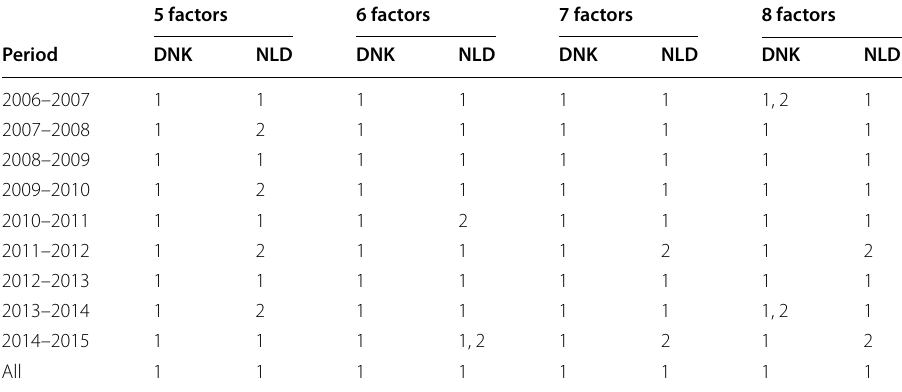
Table 6 Best-performing shortcuts to the complete multiplicative SDA, by measured distance to the true